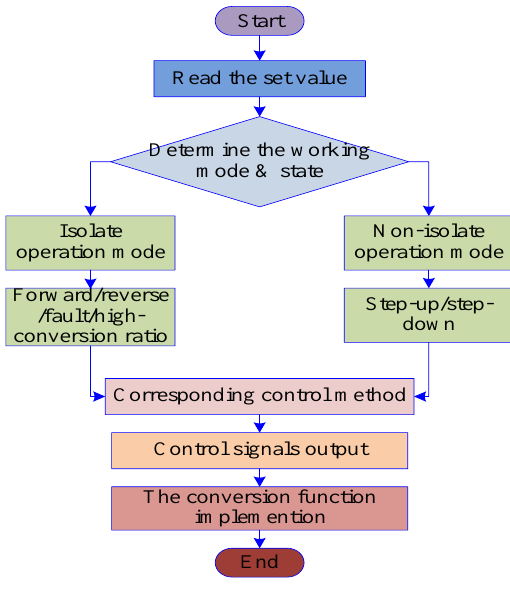
Figure 11. The control flow chart for the proposed new converter.